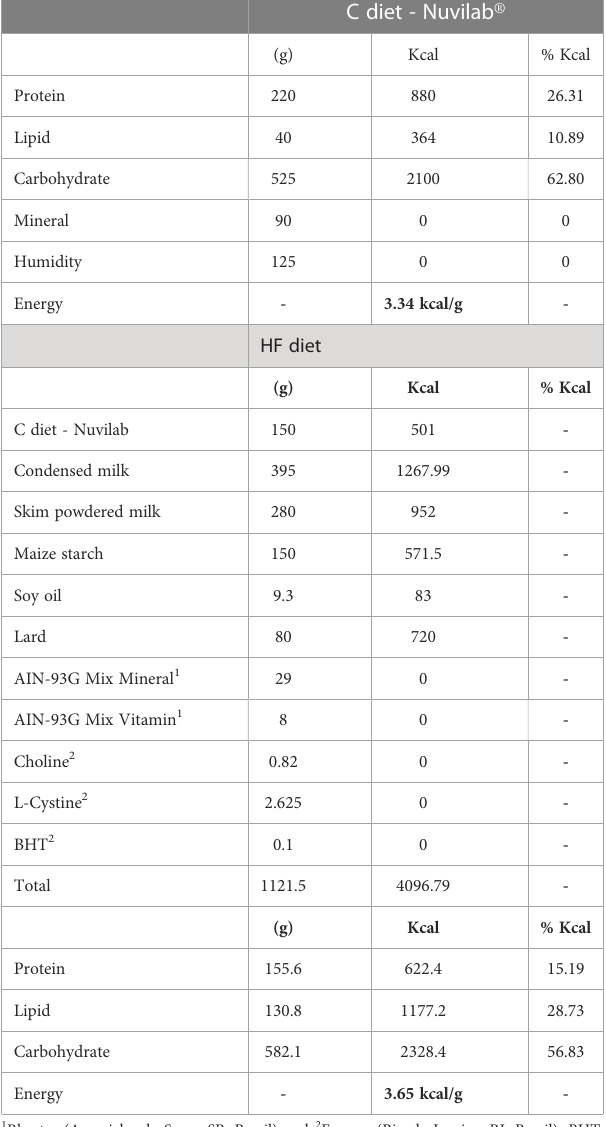
TABLE 1 Composition of the control (C) diet and high-fat (HF)